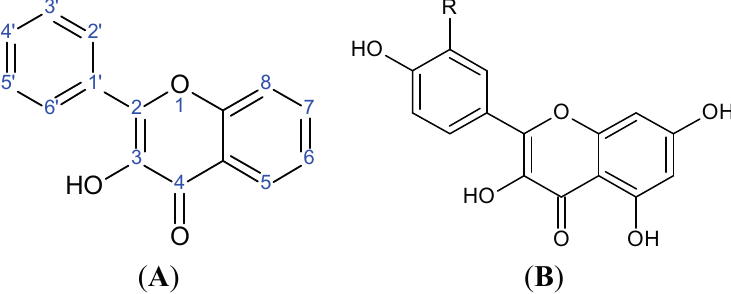
Figure 1. ( A ) General structural formula of flavonols; ( B ) structural formula of quercetin (R = OH) and kaempferol (R =